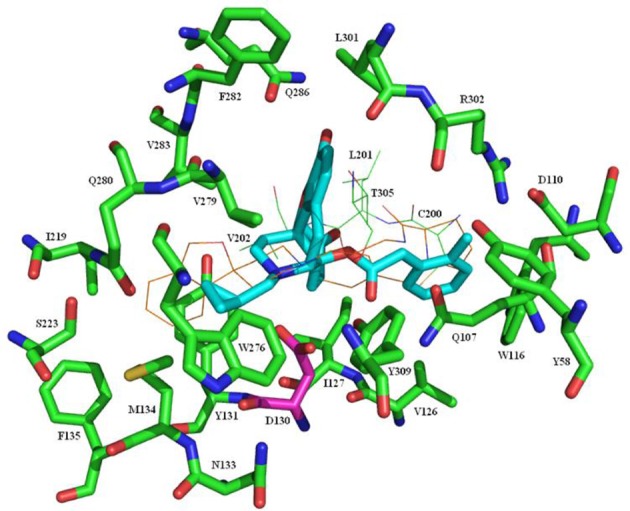
Docking of 7c in the binding site of the NOP receptor. 7c is shown with cyan carbons. The protein is shown with green carbons apart from D130 which has purple carbons. For clarity, residues C200, L201, V202, and T305 are shown as lines rather than sticks. The crystal structure ligand, C-24, is shown as lines with brown carbons.